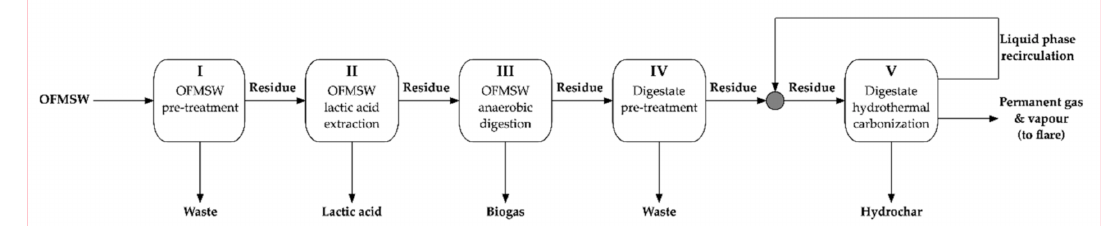
Figure 1. Sketch of the proposed integrated